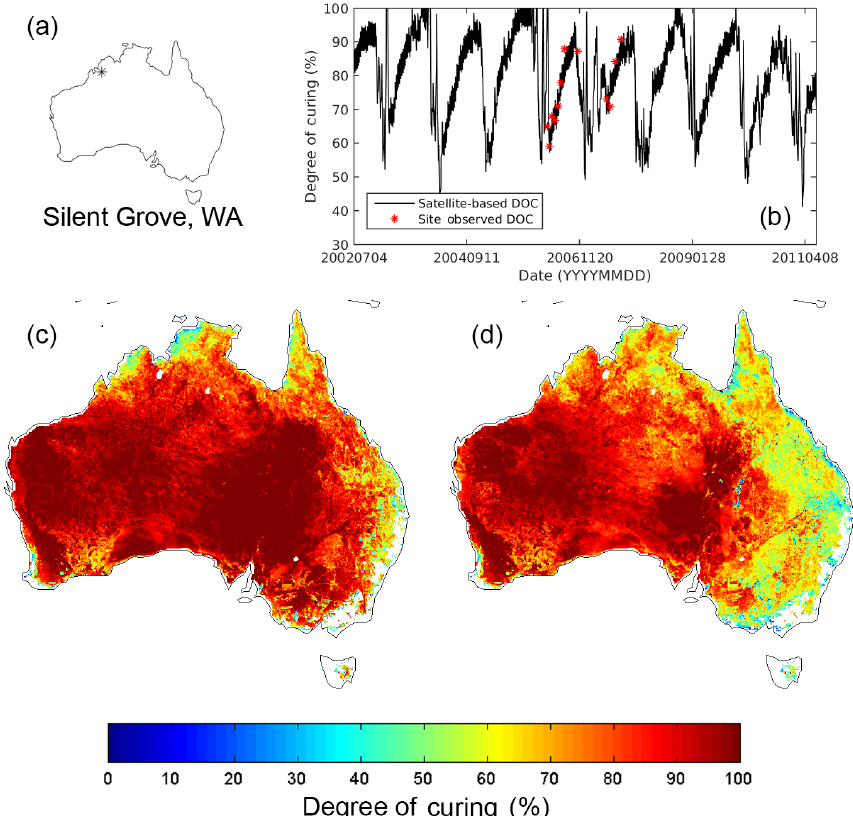
Figure 5. Example satellite-based and site-observed degree of curing (DOC) time series comparison at Silent Grove, WA (17.131 ◦ S, 125.374 ◦ E) (b) , where the star ( ∗ ) indicate the location of the time series on a map of Australia (a) . Satellite-based DOC across Australia during summer (December, January, February) for 2002–2003 (c) and 2010–2011 (d) are shown with forest areas masked out.